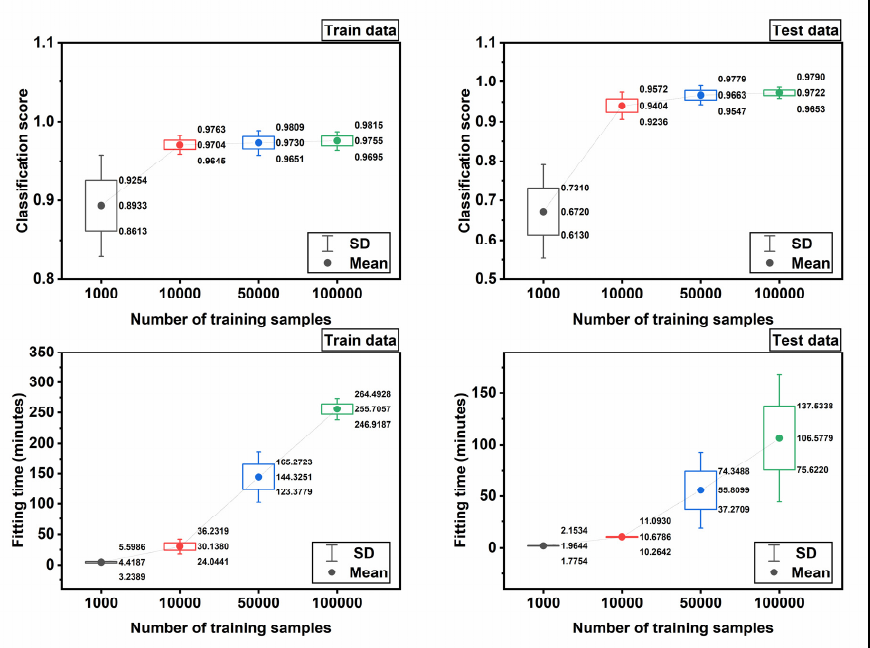
Figure 10. The plots demonstrate the results of the NN in the classification of the real train and test data sets. The mean values and standard deviations were plotted with filled circles and error bars, respectively.